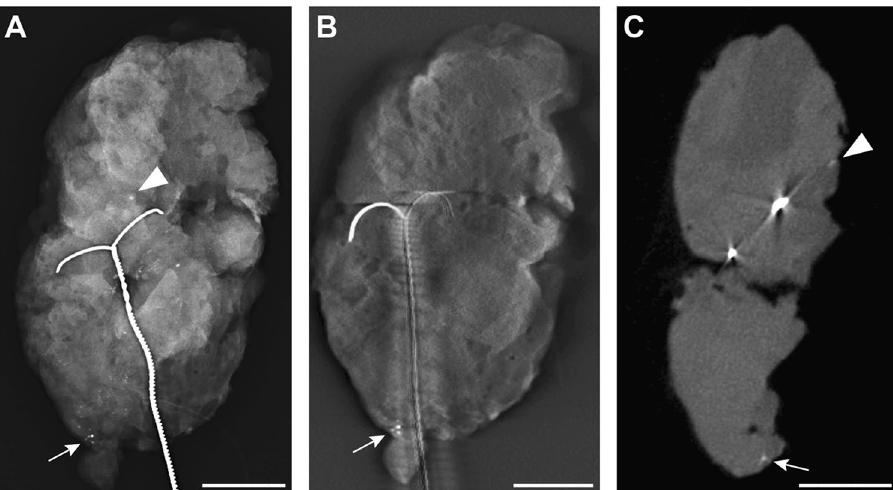
Figure 3. Breast specimen with microcalcifications, histopathologically proven as fibrocystic lesion with usual ductal hyperplasia, in ( A ) one projection of mammography (DM), ( B ) the same projection of digital breast tomosynthesis (DBT) and ( C ) cone-beam computed tomography (CBCT). Although microcalcifications can be detected directly at the lower margin in all modalities (arrow), there are other microcalcifications that are only clearly detected in DM and CBCT (arrowhead). Here, direct contact to the margin is exclusively seen in the CBCT (arrowhead). Again, metal-related artifacts around the wires are seen in ( B ) DBT and ( C ) CBCT images. The white scalebar indicates 1